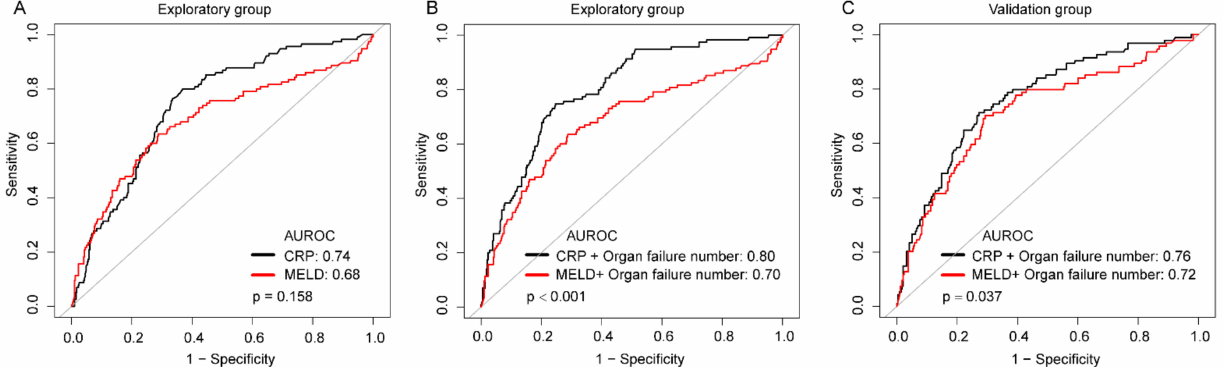
Figure 2. Predictive performance of CRP in 30-day CSI. ( A ) Receiver operated characteristic (ROC) curves for the established MELD score and biomarkers of systemic inflammation in relation to 30-day CSI. ( B ) Receiver operated characteristic (ROC) curves for the combination of organ failure number and CRP or MELD score in exploratory group. ( C ) Receiver operated characteristic (ROC) curves for the combination of organ failure number and CRP or MELD score in the validation